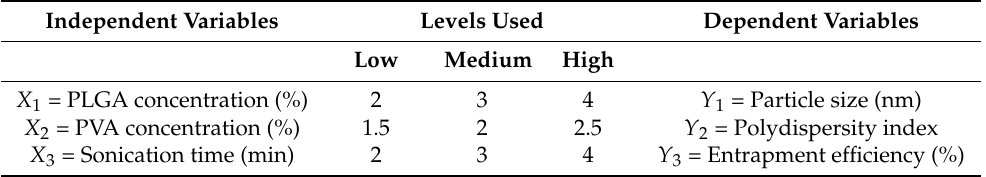
Table 1. Various independent and dependent variables used in the Box–Behnken design for the preparation of TQ-CS-PLGA-NPs.